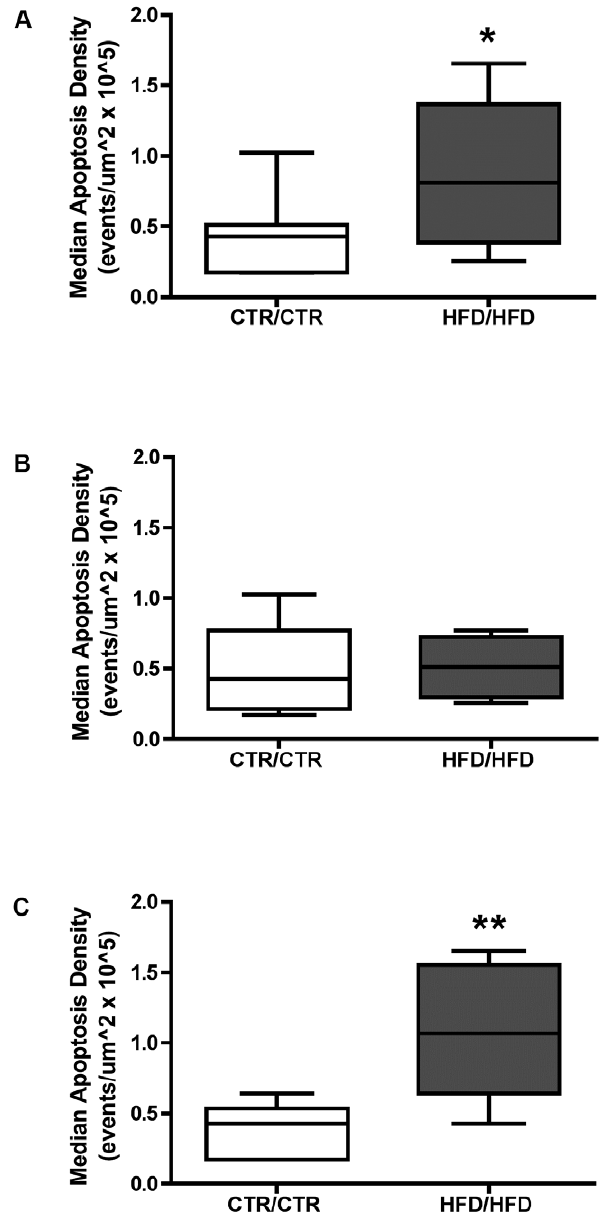
Figure 1. Quantification of hepatic apoptosis between CTR/CTR and HFD/HFD juvenile macaques as determined by TUNEL staining. (A) Quantification of hepatic apoptosis between entire cohort of juvenile macaques. (B) Comparison of apoptosis in female juvenile macaque liver between CTR/CTR and HFD/HFD diet groups. (C) Quantification of apoptosis in male juvenile macaque liver between CTR/CTR and HFD/HFD diet groups. CTR/CTR n=11, 6 males 5 females; HFD/HFD n=10, 6 males, 4 females. ( *= p , 0.05, ** = p , 0.01).